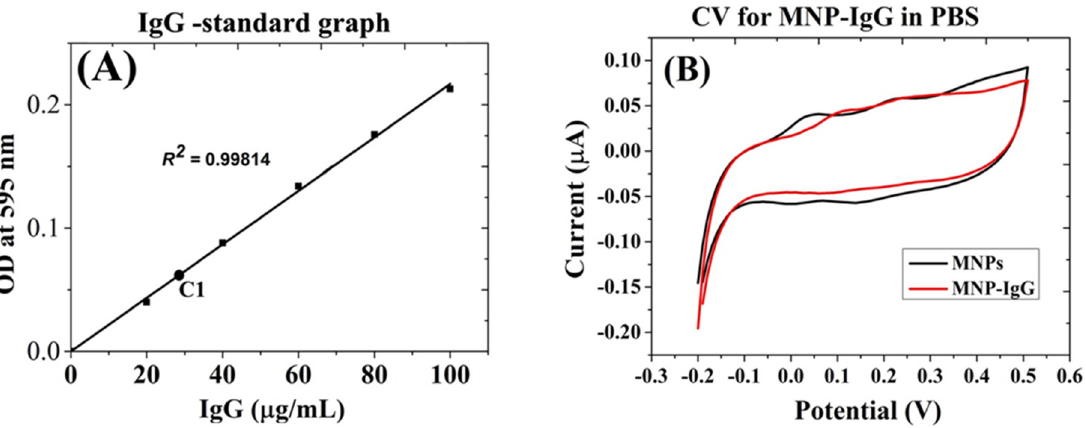
Figure 3. Preparation of Anti- E. coli IgG-MNPs conjugates. ( A ) Bradford assay standard graph for anti- E. coli antibody IgG (‘C1’ denotes the IgG-conjugated MNPs). ( B ) CV of MNPs and IgG-MNP conjugate in PBS.